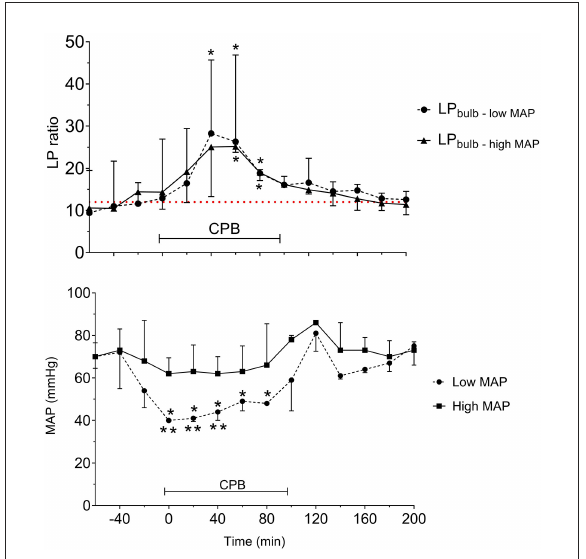
FIGURE12 Acute effects of cardiopulmonary bypass (CPB) and two levels of mean arterial blood pressure (MAP) on lactate/pyruvate (LP) ratio obtained from a microdialysis catheter placed in the jugular bulb (upper panel) and the simultaneous MAP levels (lower panel). Data are shown as median (IQR). The interrupted line (upper panel) indicates reference level (Mean) for LP ratio in human jugular venous blood (43). * Significant difference from baseline. ** Significant difference between corresponding datapoints by one-way analysis of variance and corrected for multiple comparisons using the Bonferroni test ( α = 0.006). Values are median and error with inter quartile range ( n = 10). Figures by permission from